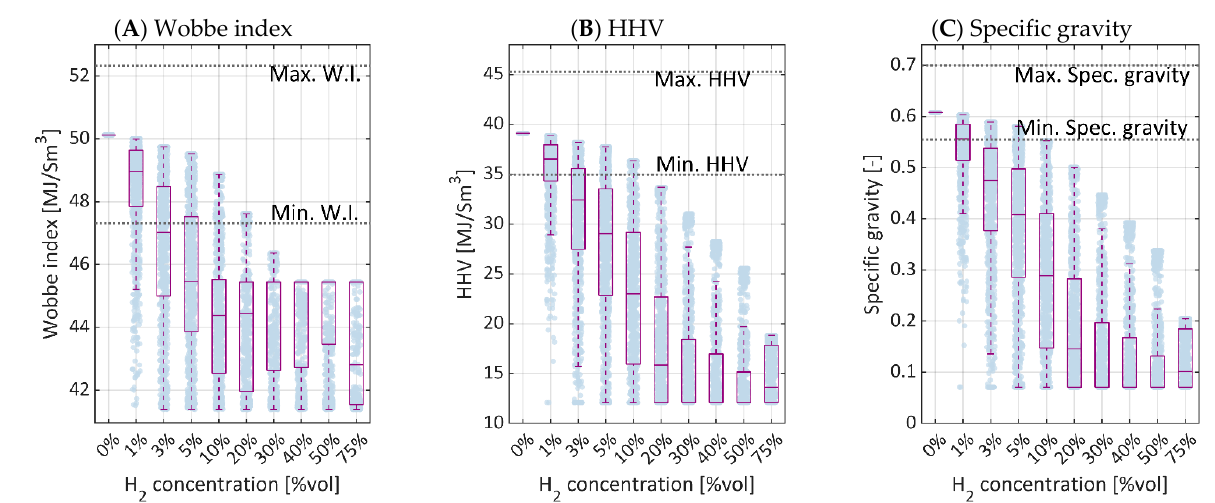
Figure 8. Physical properties of the H 2– NG blend received by the most disadvantaged load (i.e., the consuming node with highest % H 2 ) in 1000 networks.